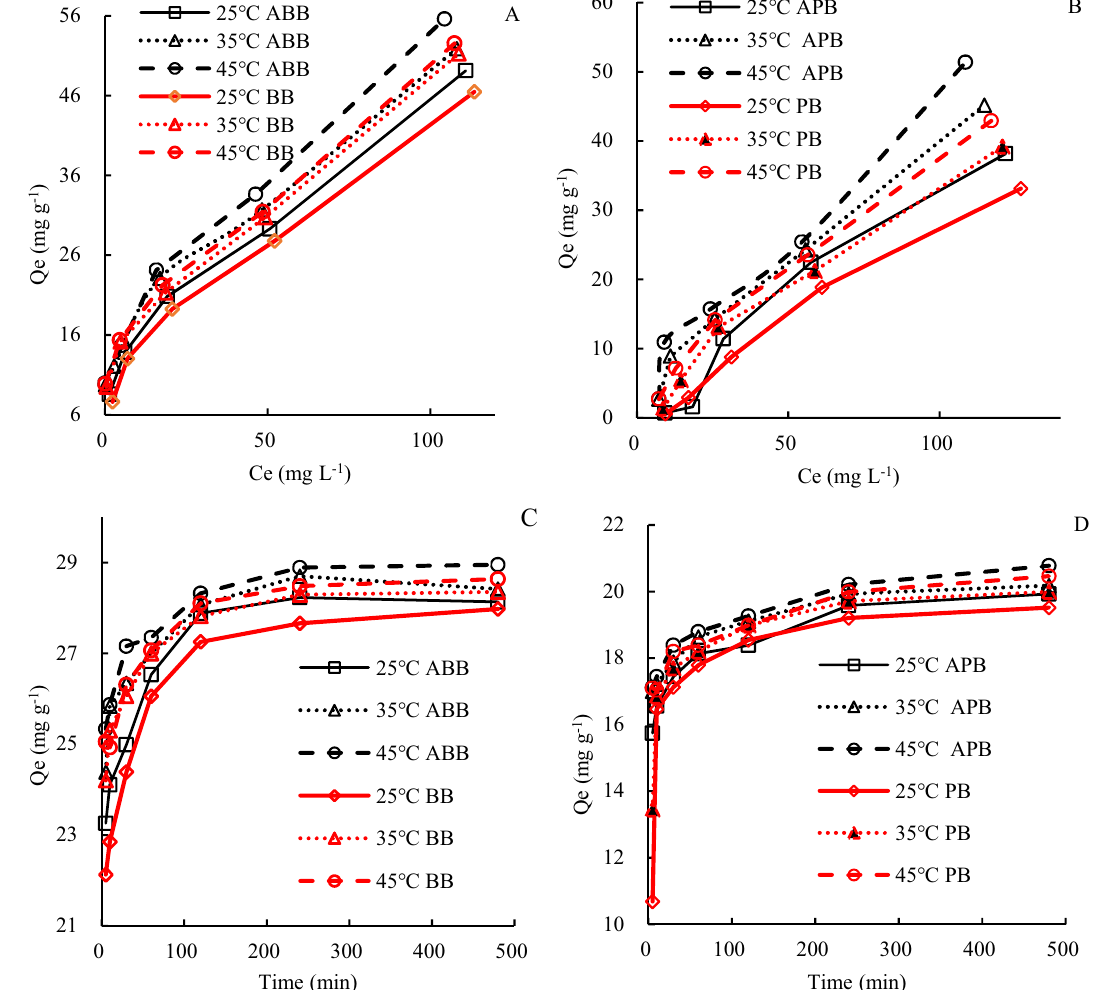
Figure 5. Adsorption with different initial concentration [( A ) Bush biochar; ( B ) Peanut biochar)] and time [( C ) Bush biochar; ( D ) Peanut biochar)] with different solution temperature.